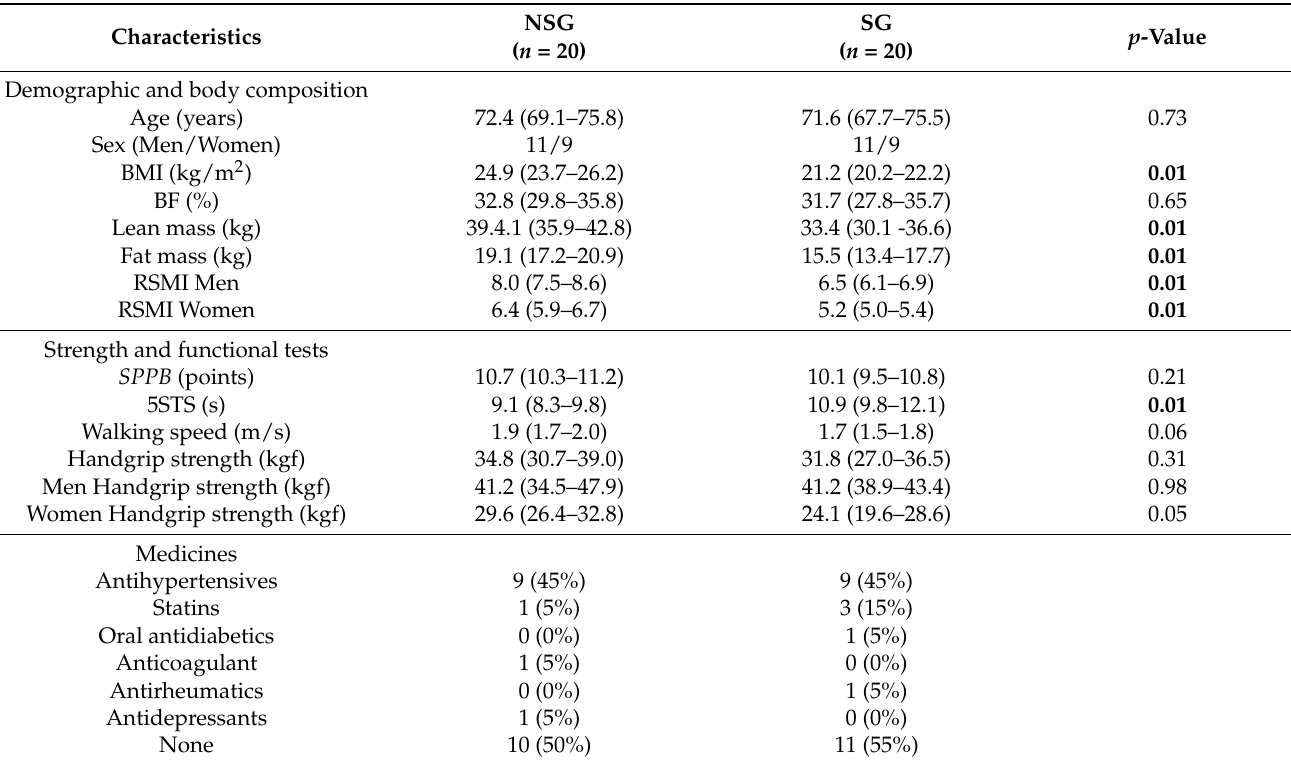
Table 1. Clinical, demographic and functional characteristics of participants at